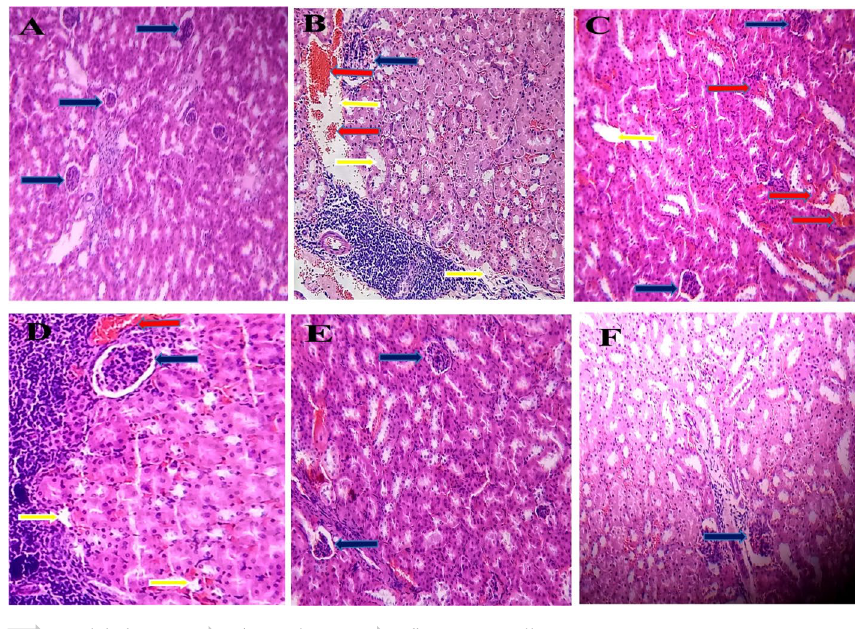
Fig. 3 Effect of Melastoma malabathricum extracts at different conc. on the kidney in HCD mice. a Normal group: Histopathology demonstrated the average size of the glomerulus (blue arrow) without any accumulation of fatty layers or globules. b Hyperlipidemic control: Exacerbated and enlarged glomerulus (blue arrow) due to the deposition of fat molecules as well as the presence of inflammatory cells in the blood vessels (red arrow). c MFA-500 mg/kg: The glomerulus was a little bit larger (blue arrow), demonstrating the presence of inflammatory cells (red arrow) and enlarged fat globules (yellow arrow) after performing histopathology analysis. d MSE-250 mg/kg: A bit expanded glomerular size (blue arrow), some fat globules deposition (yellow arrow), and also appeared minute inflammatory cells in the blood vessel (red arrow). e MSE-500 mg/kg: The histopathology of the tested drug with this conc. Exhibited typical infrastructure of glomerulus and no prominent sign of fats deposition. f ATOVAT-20 mg/kg: Similar histopathology was observed compared to the normal group. (Pictures magnification 20X)